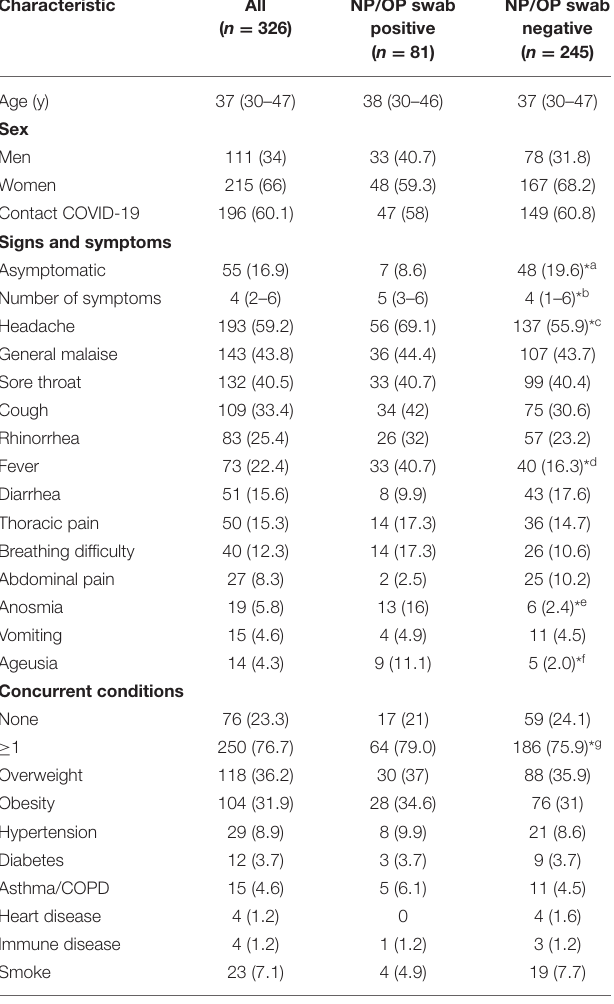
TABLE 4 | Clinical characteristics of the adult participants included in this study.